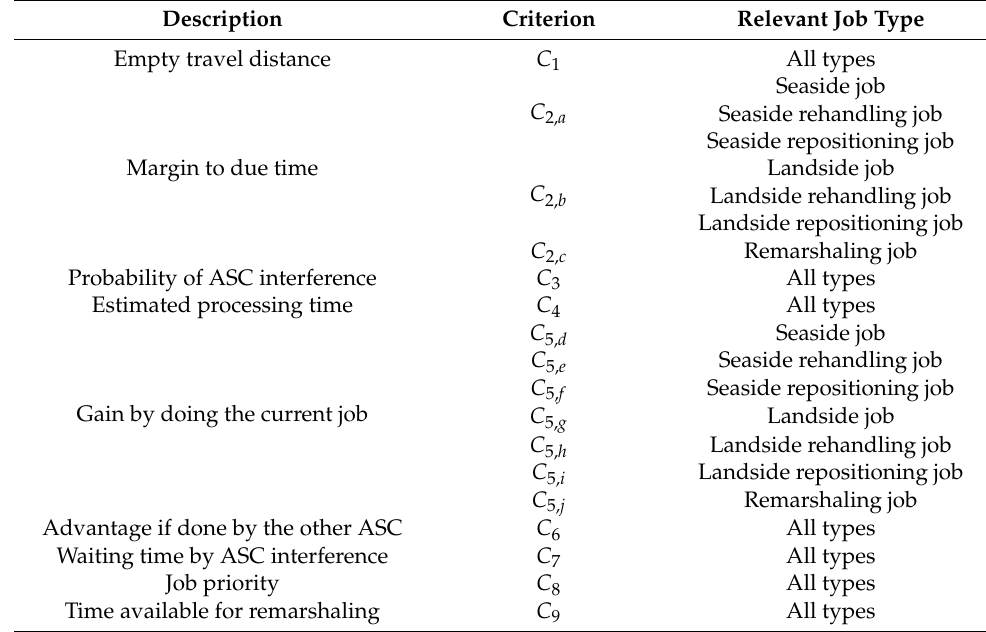
Table 1. Evaluation criteria for different job types for the crane dispatching